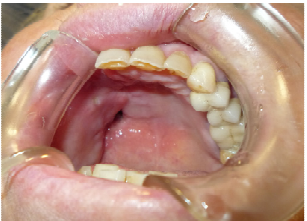
Figure 4. Initial application of the protection plate.